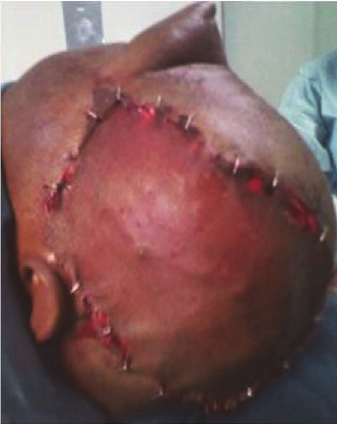
Figure 5: Skin graft used to cover the temporoparietal flap and the temporalis